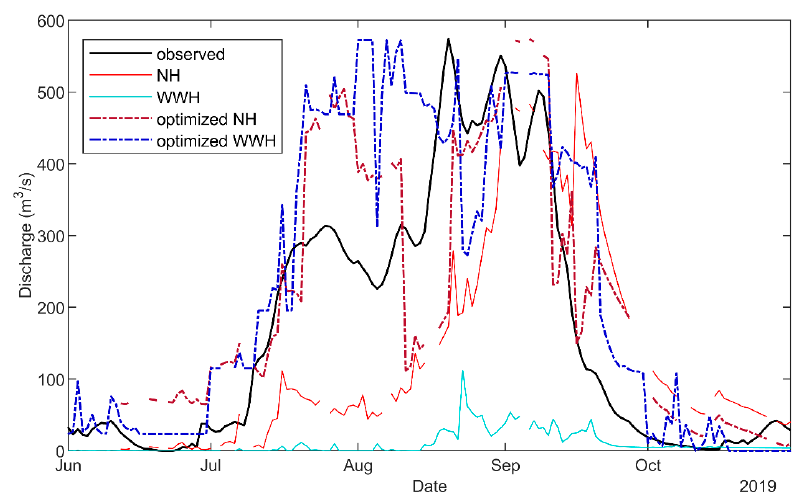
Figure A1. Flow duration curve of the Sirba River at Bossey Bangou in the validation year 2019. Observed flow, NH and WWH (5 day) forecasts before and after the optimization.